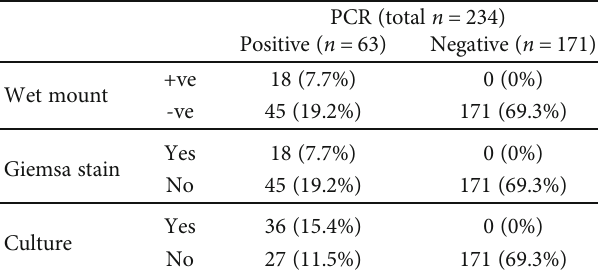
Figure 1: Gel electrophoresis of ampli fi ed DNA products of the Actin gene. L: 100bp ladder. Lanes 1 and 2: negative and positive controls, respectively. Lanes 3 and 4: positive and negative samples, respectively. Table 2: Results of the used diagnostic methods.